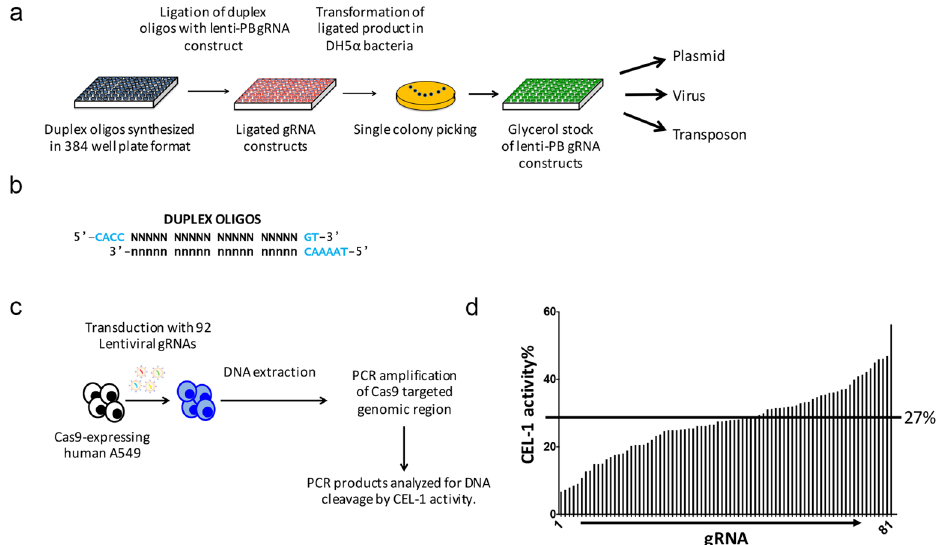
Figure 4. ( a ) Schematic showing the cloning strategy of the sgRNA libraries in multi well plate format. ( b ) Duplex oligos synthesized for cloning in the lentiviral-PB sgRNA vector. ( c ) Schematic illustrating the experimental strategy for validation of 92 sgRNAs chosen from the human genome wide sgRNA library. ( d ) CEL-1 activity results indicating the cutting efficiency of 81 out of 85 samples which produced a PCR product indicating success rate of 95% functional sgRNAs. Average cutting efficiency of 27% is